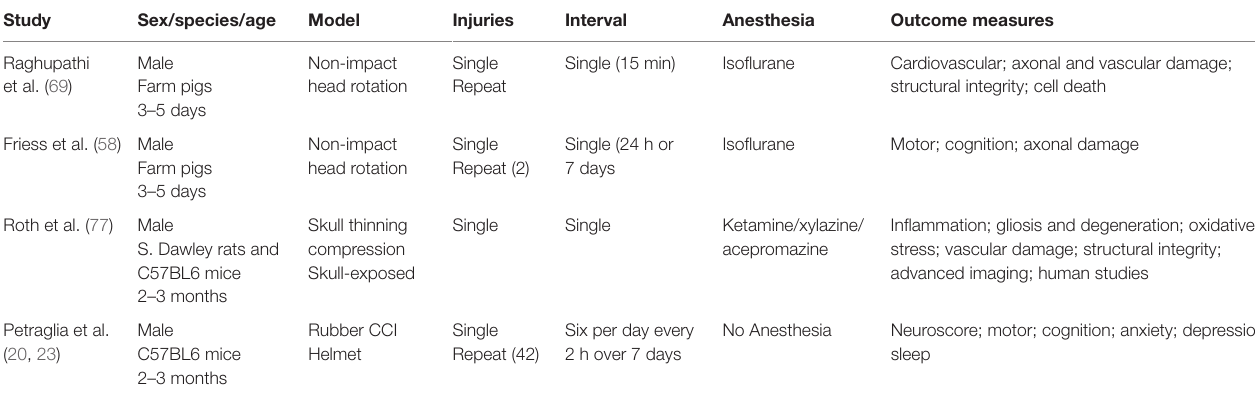
TABLe 6 | Other in vivo TBi